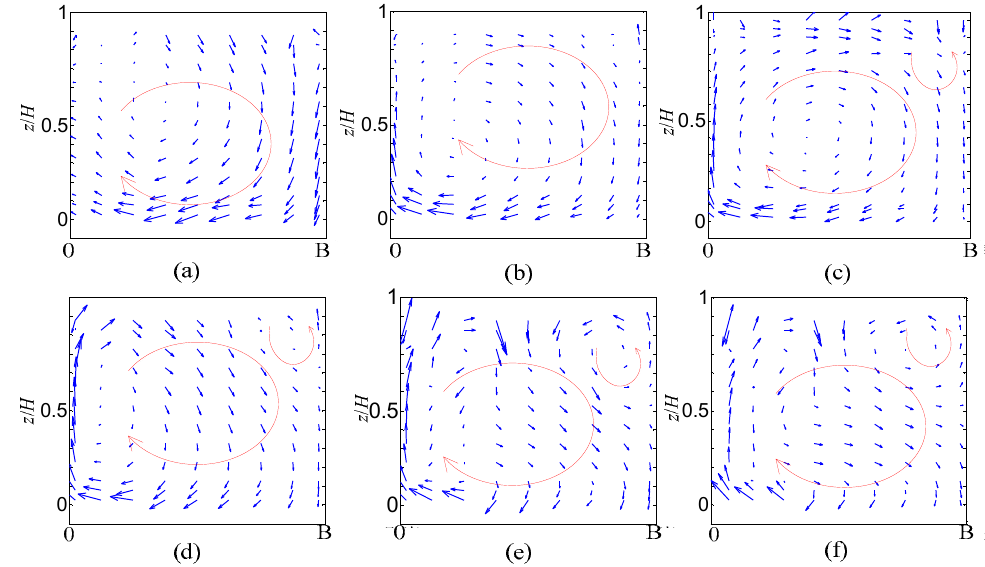
Figure 11. The distributions of transverse circulation for sections: ( a ) D0, ( b ) D30, ( c ) D60, ( d ) D90, ( e ) D150,( f ) ( e ) D150,( f ) D180.